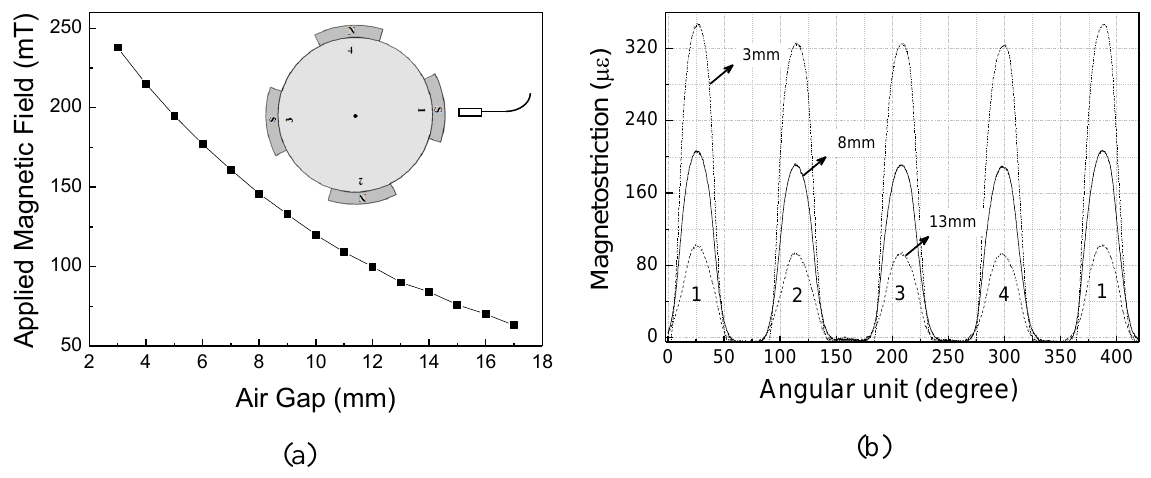
from the pole surface number 1 (inset depicts the setup); (b) angular magnetic field distribution for different air